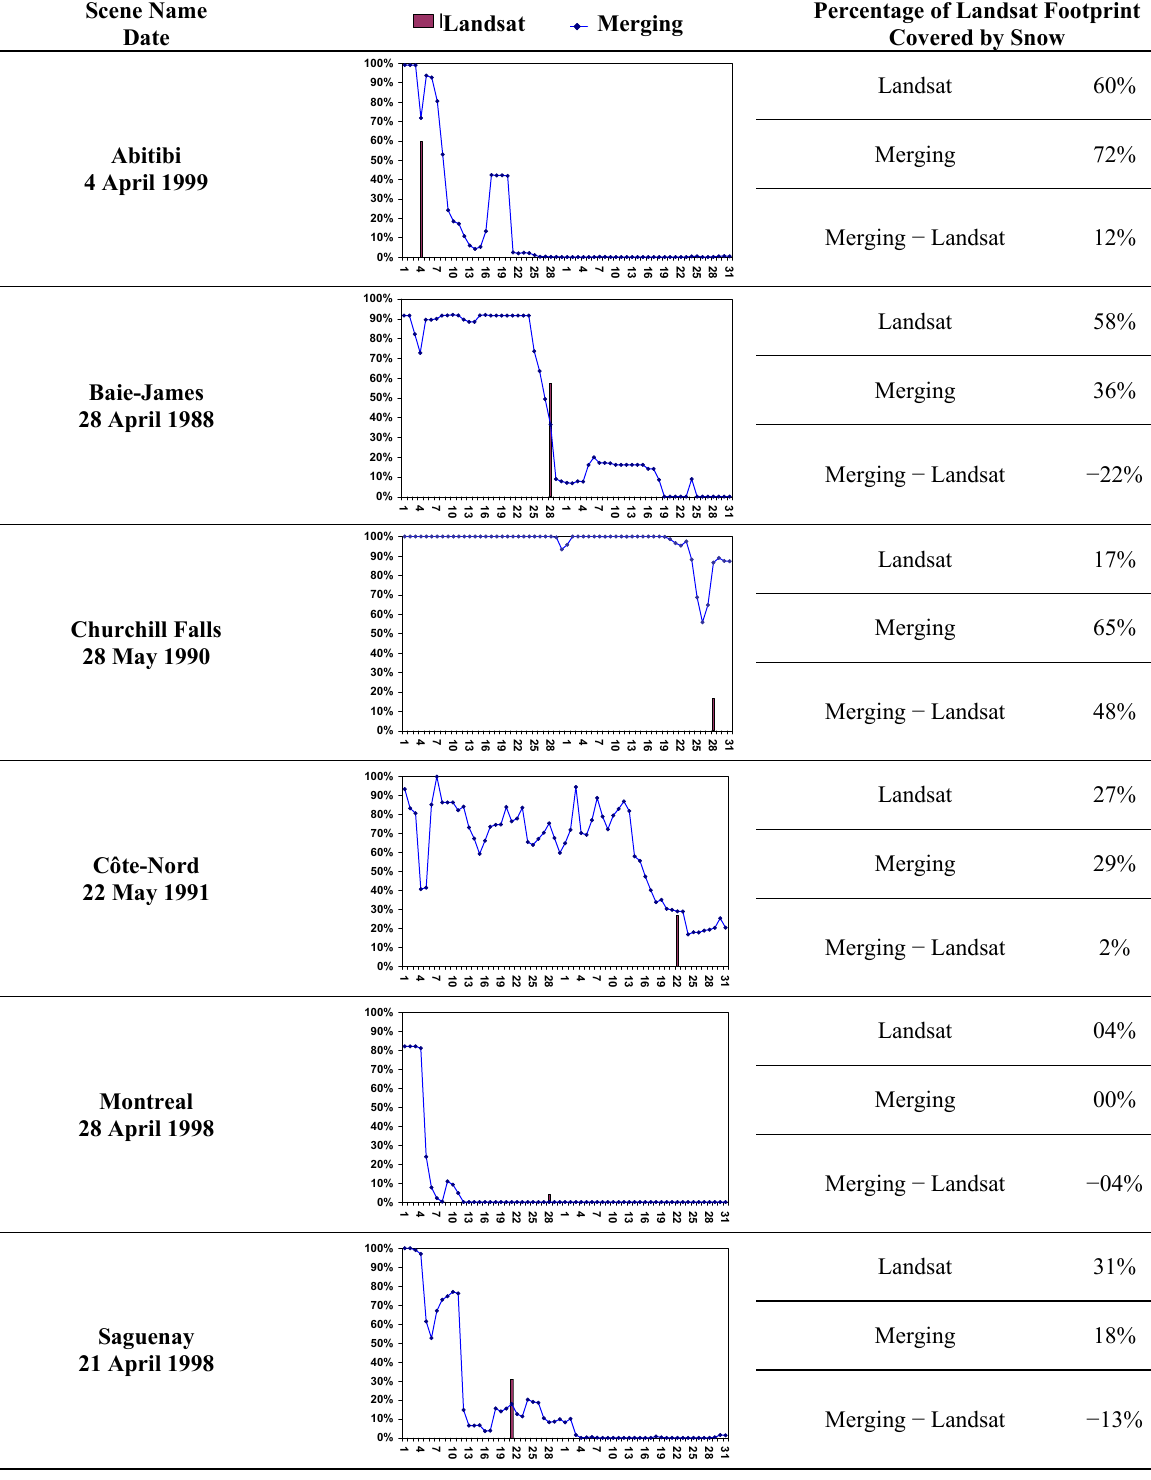
Table 8. Percentage of snow cover in the six Landsat-TM footprints, calculated from snow maps generated from the Landsat-TM imagery and maps produced by the proposed merging algorithm (from April 1 to May 31 of each